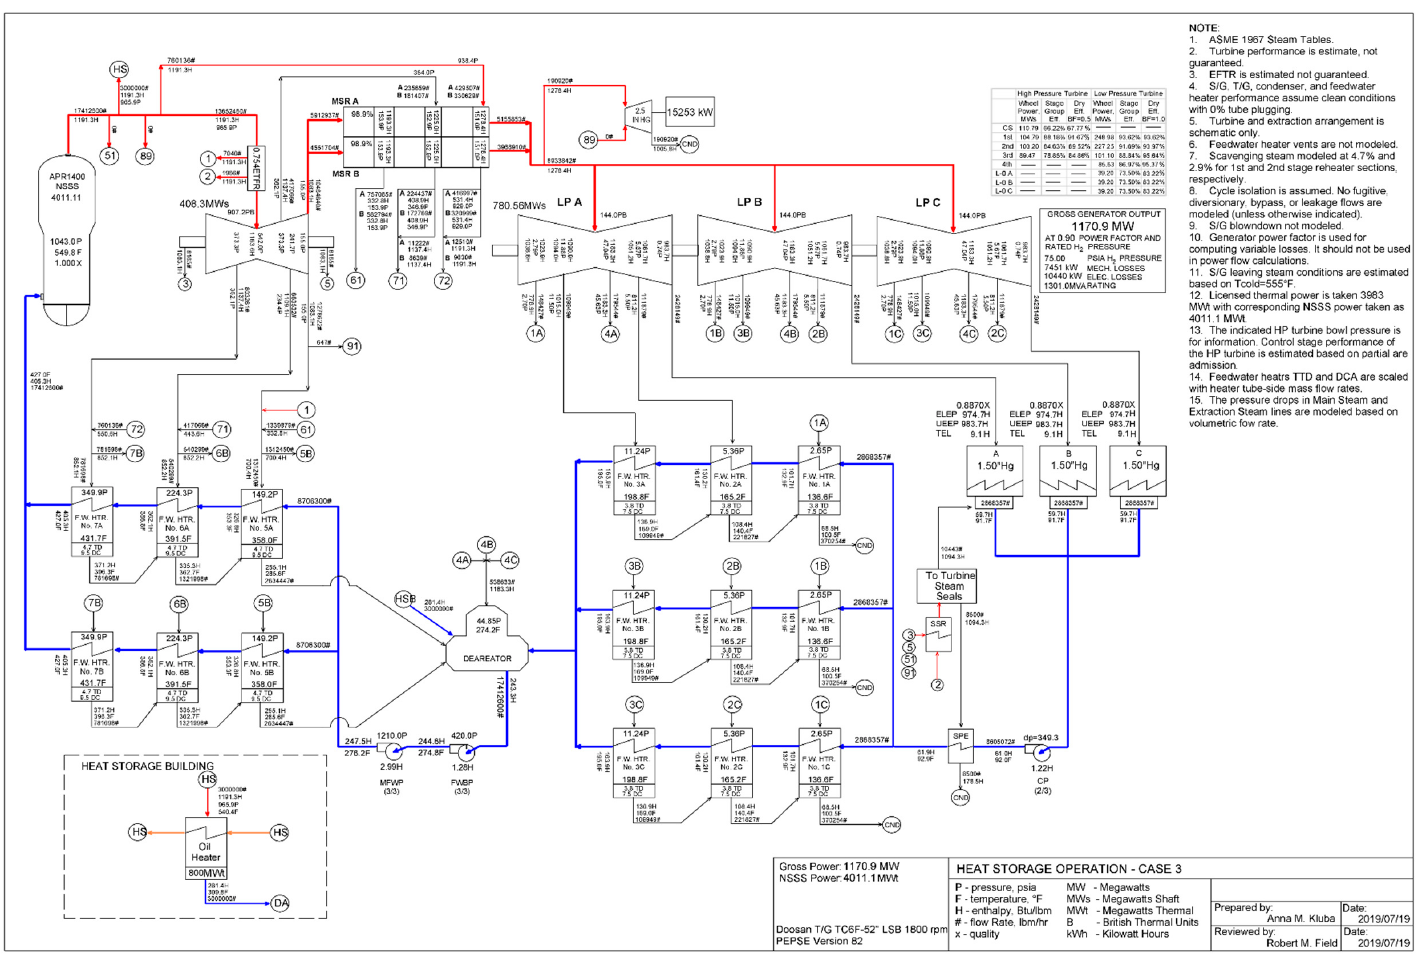
Figure A1. APR1400 NHS&R heat balance diagram under heat storage operation—Case 3 (PEPSE TM results). The abbreviations are explained in the Abbreviations List.